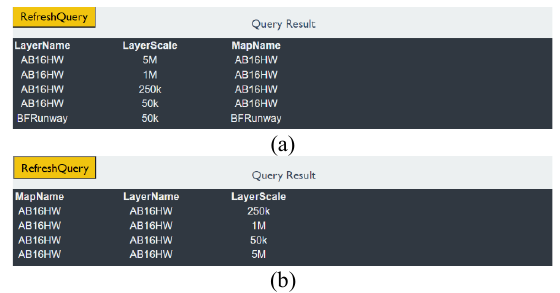
Figure 7 . Results of finding (a) Layer that contain “B” in name.